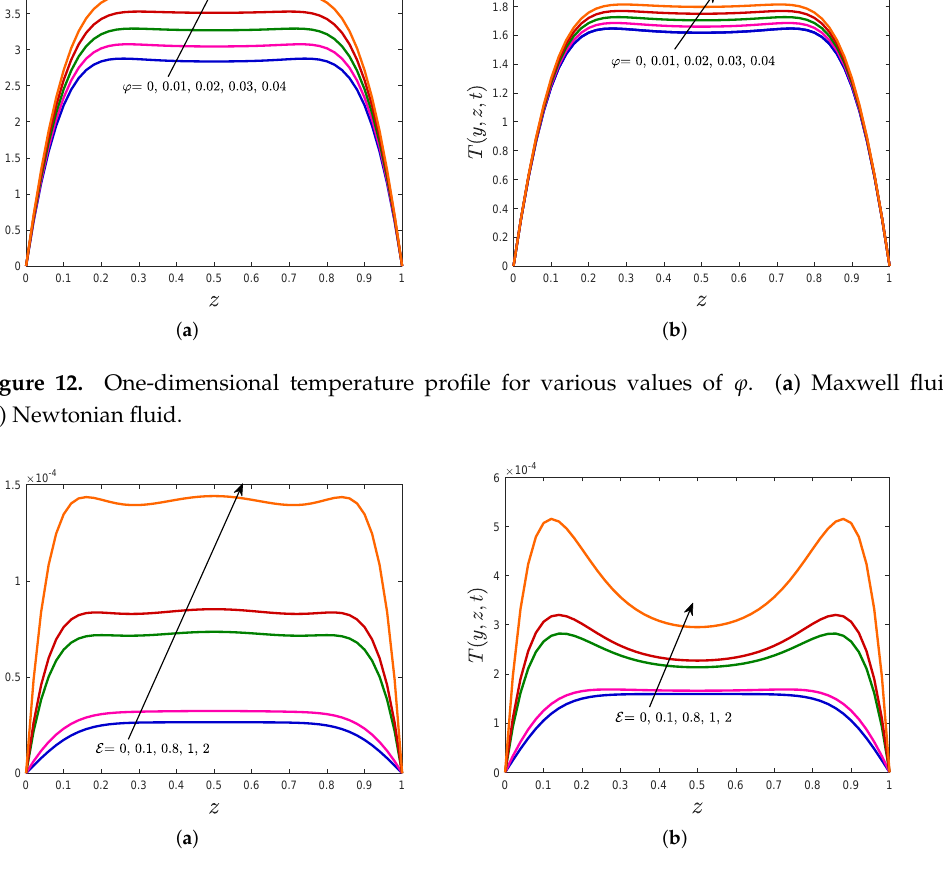
Figure 13. One-dimensional temperature profile for various values of E . ( a ) Maxwell fluid, ( b ) Newtonian